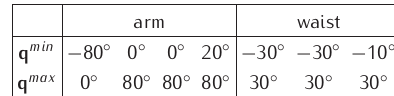
Table 1. Joints limits of the iCub robot simulator.